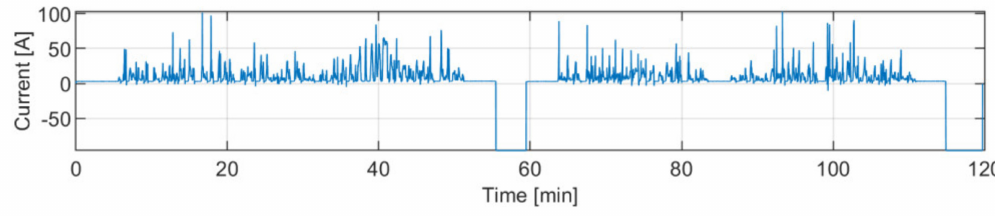
Figure 2. Most likely current profile at cell